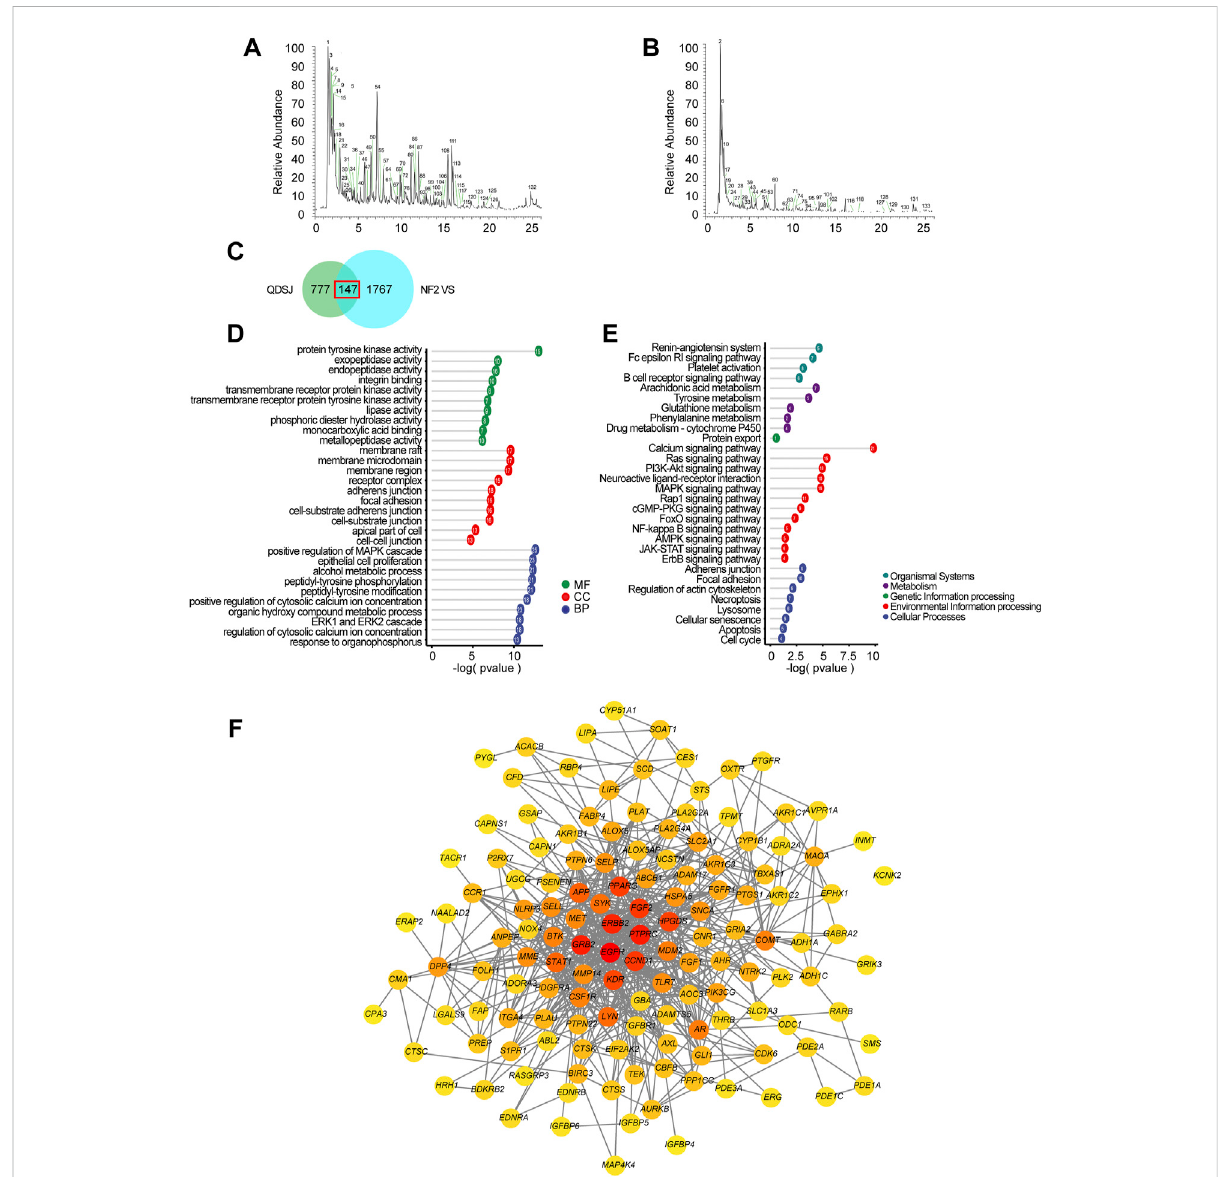
FIGURE 2 Component-target-pathway analyses of QDSJ decoction in the treatment of NF2-associated VS. (A) Positive mode mass spectrum chromatogramsofQDSJdecoction. (B) NegativemodemassspectrumchromatogramsofQDSJdecoction. (C) Venndiagramofthedrugtargetsof QDSJdecoctionanddifferentiallyexpressedgenesinNF2-associatedVS. (D) GOtermsassociatedwiththeoverlappingcandidatetargetsofQDSJin the treatment of NF2-associated VS. The top 10 GO functional categories in molecular function, cellular component, and biological process wereselected. (E) KEGGpathwayenrichmentoftheoverlappingcandidatetargetsofQDSJinthetreatmentofNF2-associatedVS. (F) PPInetworkof the overlapping genes of QDSJ decoction and NF2-associated VS. The darker color indicates a higher degree. MF: molecular function; CC: cellular component; BP: biological